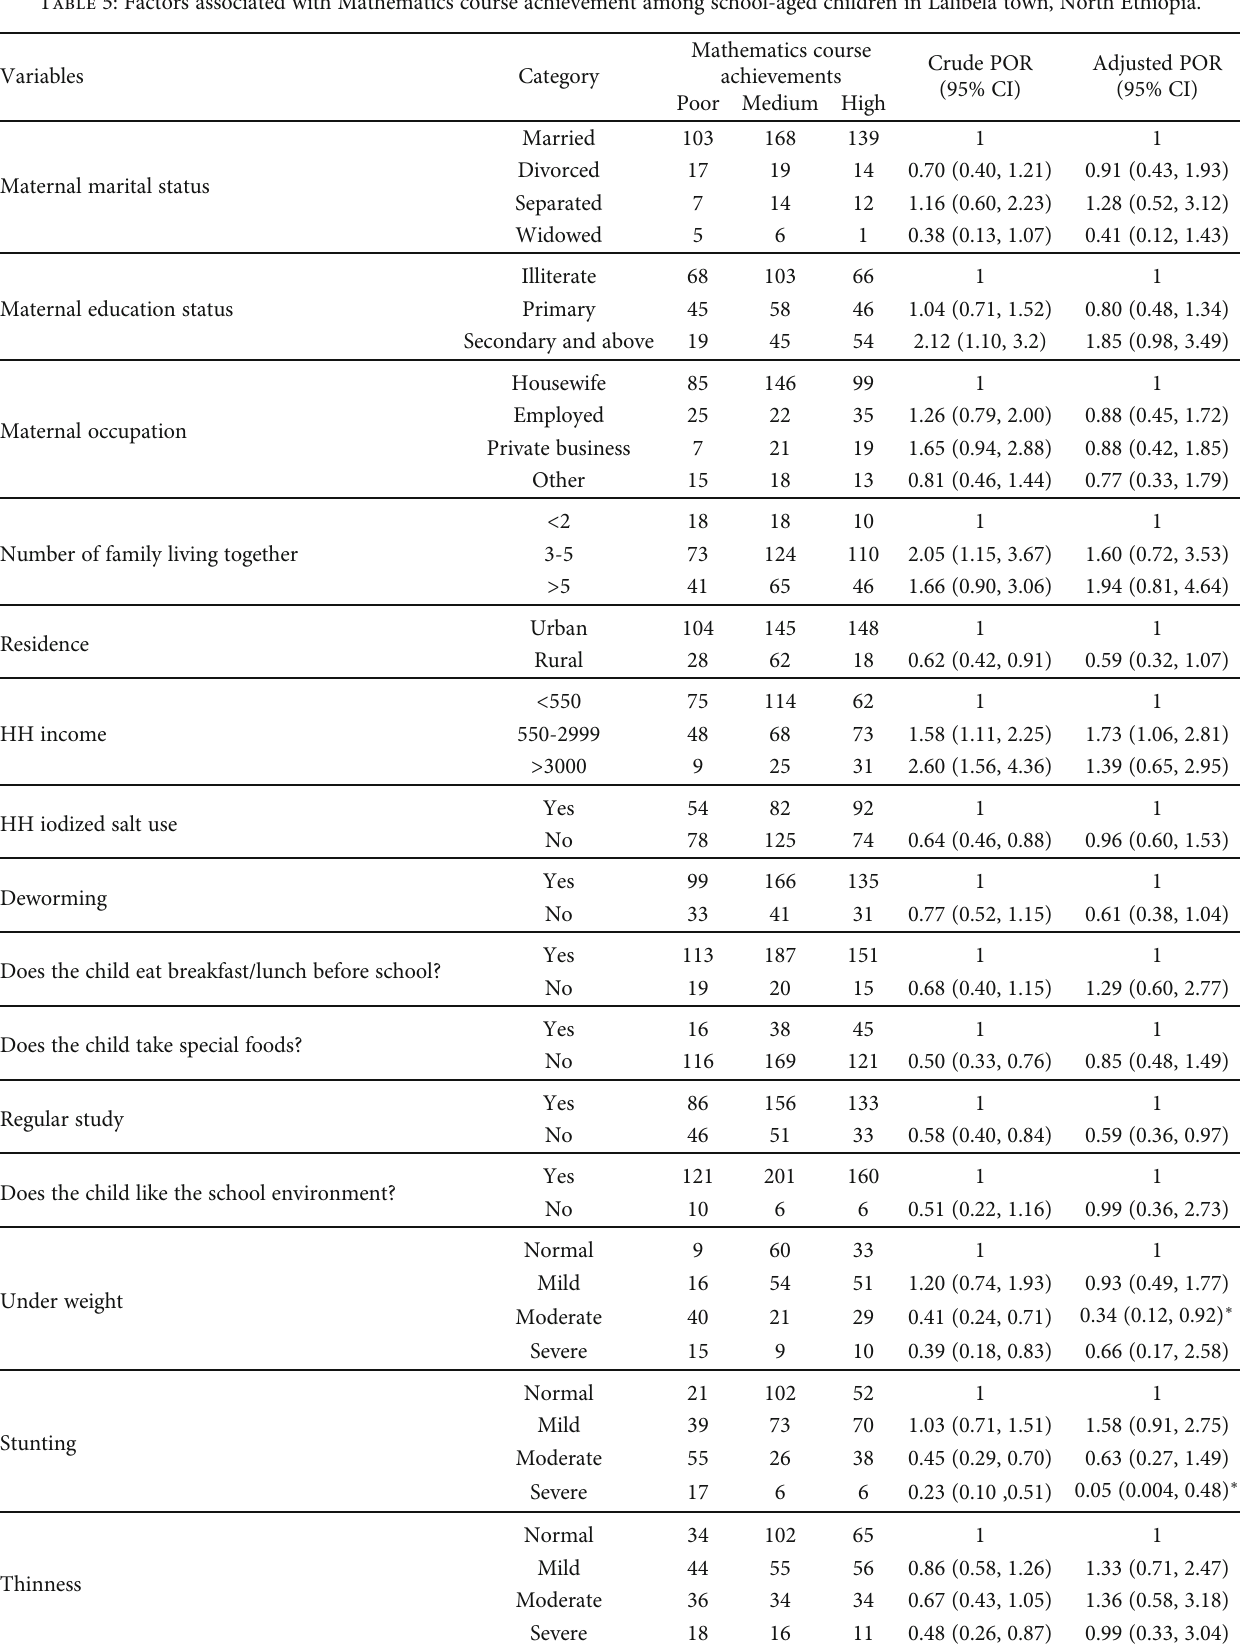
Table 5: Factors associated with Mathematics course achievement among school-aged children in Lalibela town, North